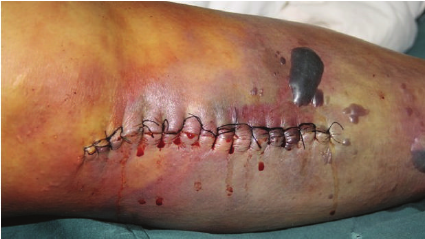
Figure 1: The limb was severe swollen and skin was brownish with bullae exuding from the incision.